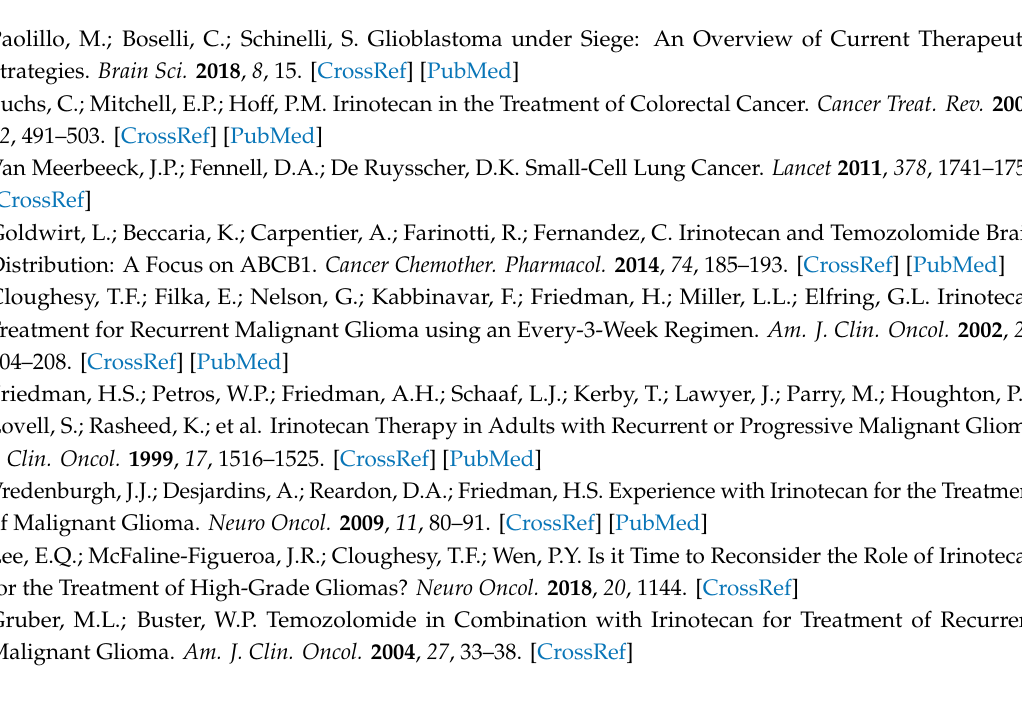
Figure S1: Blots from Figure 2A,B, Figure S2: TOP1 and TDP1 protein levels measurements in di ff erent sets of GBM cell lines to assess potential correlation with irinotecan IC 50 , Figure S3: Topoisomerase I (TOP1) activity in replicated sets of GBM cell line experiments does not correlate with TOP1 protein levels or irinotecan IC 50 , Figure S4: TDP1 activity levels show slight correlation with irinotecan IC 50 , Figure S5: TDP1 / TOP1 activity ratio is a stronger predictor than TDP1 / TOP1 protein ratio for irinotecan IC 50 , . Figure S6: Blots from Figure 6A. Figure S7: Blots from Figure 8B and 8E; Table S1: Relative TOP1 and TDP1 protein expression levels in GBM cell lines, Table S2: Pearson correlation of TOP1 and TDP1 protein or activity, TDP1 / TOP1 protein or activity ratio with experimental IC 50 of irinotecan, Table S3: TOP1 activity levels in GBM cell lines, Table S4: Pearson correlation of protein level with activity level of TOP1 and TDP1 in GBM cell lines and tumors, Table S5: TDP1 activity levels in GBM cell lines, Table S6: Pearson correlation between TOP1 levels and TDP1 levels in GBM cell lines and GBM patient tumors, Table S7: TDP1 / TOP1 ratios in GBM cell lines, Table S8: Glioblastoma patient information, Table S9: TOP1, TDP1, and TDP1 / TOP1 ratio in GBM patient tumors, Table S10: Drug sensitivity z-scores of topoisomerase inhibitors for GBM cell lines in the NCI-60 panel, Table S11: Pearson correlation of TOP1 and TDP1 protein or activity, TDP1 / TOP1 protein or activity ratio with z-score of topoisomerase inhibitors, Table S12: Information on primary and secondary